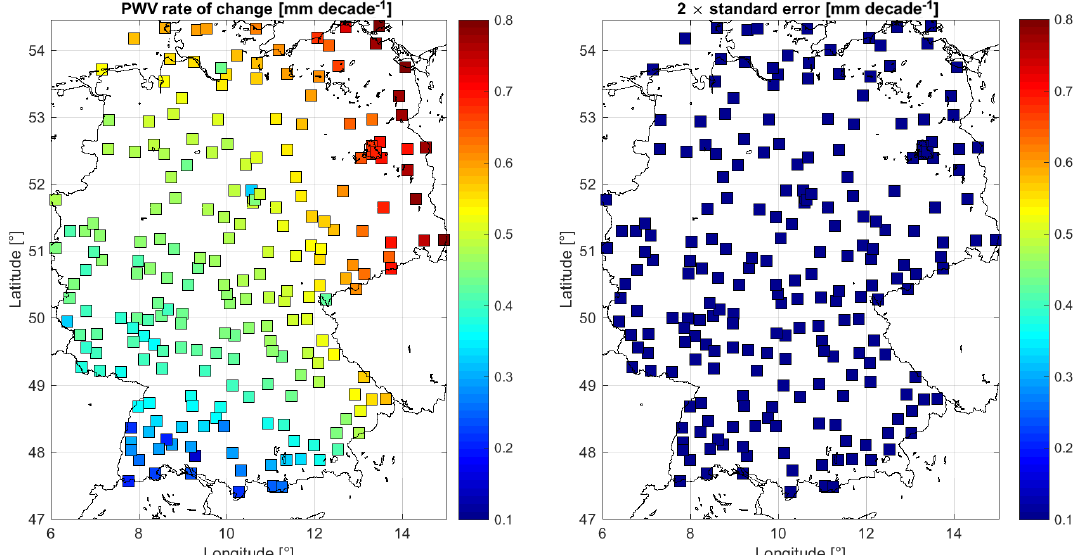
Figure 11. Estimated trends using dew-point-based PWV and the corresponding standard error of the estimated slope.